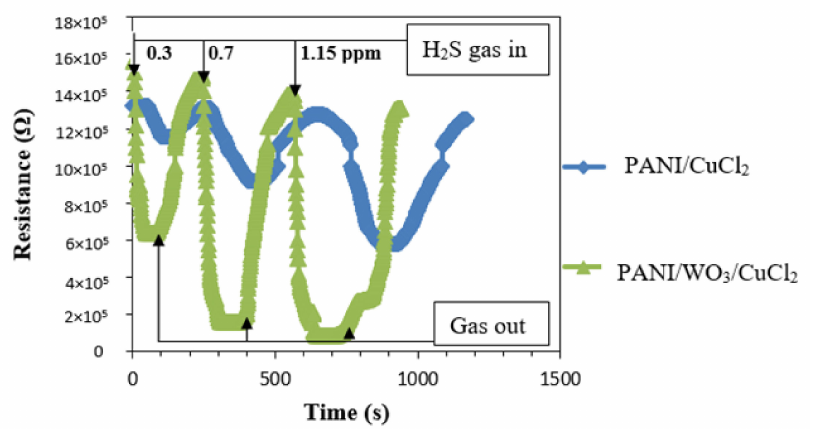
Figure 22. Change in resistance of PANI/CuCl 2 and PANI/WO 3 /CuCl 2 -based sensors with time.